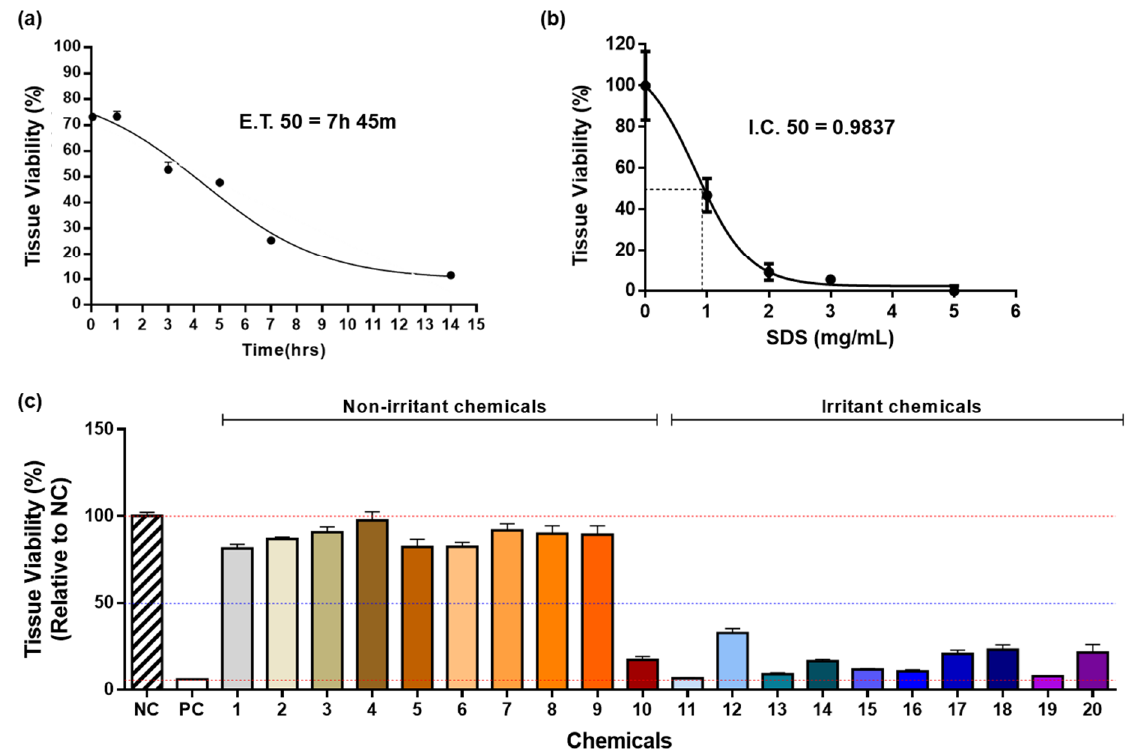
Figure 3. List of chemical-toxicity test substances recommended by OECD guidelines. ( a ) relative viability of self-assembled RSE model according to 1% Triton X-100 treatment time and exposure time required to reduce tissue viability by 50% ( n = 3); ( b ) relative viability of the self-assembled RSE model according to various SDS concentrations and inhibitory concentration required to reduce tissue viability by 50% ( n = 3); ( c ) tissue viability in self-assembled RSE models for 20 substances ( n = 3). Different colors represent each chemical. NC: Negative control; PC: Positive control.